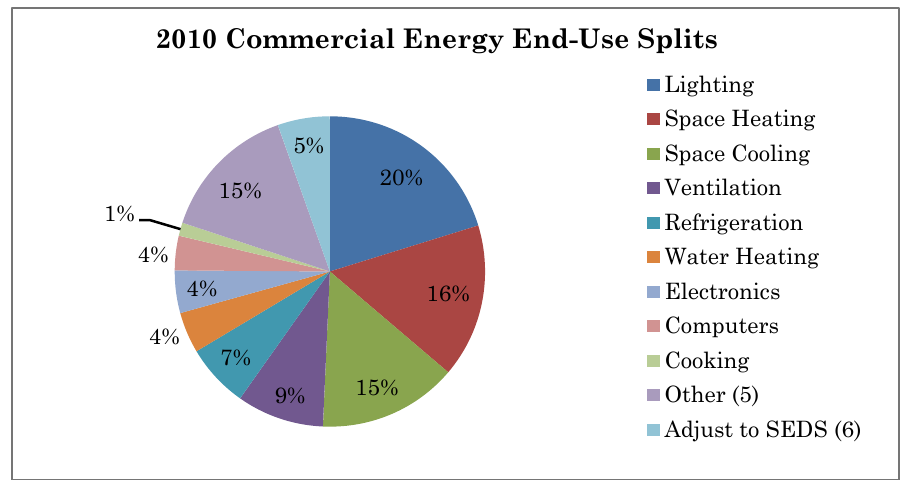
Figure 1. Energy End-use split for commercial building in 2010 [ 1 ] .